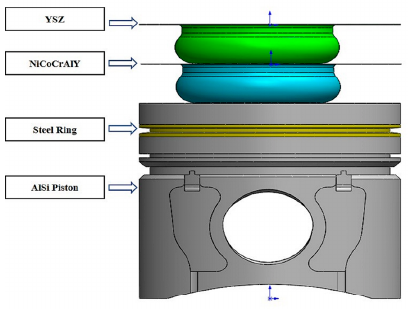
Figure 4. Thermal barrier coating piston model.